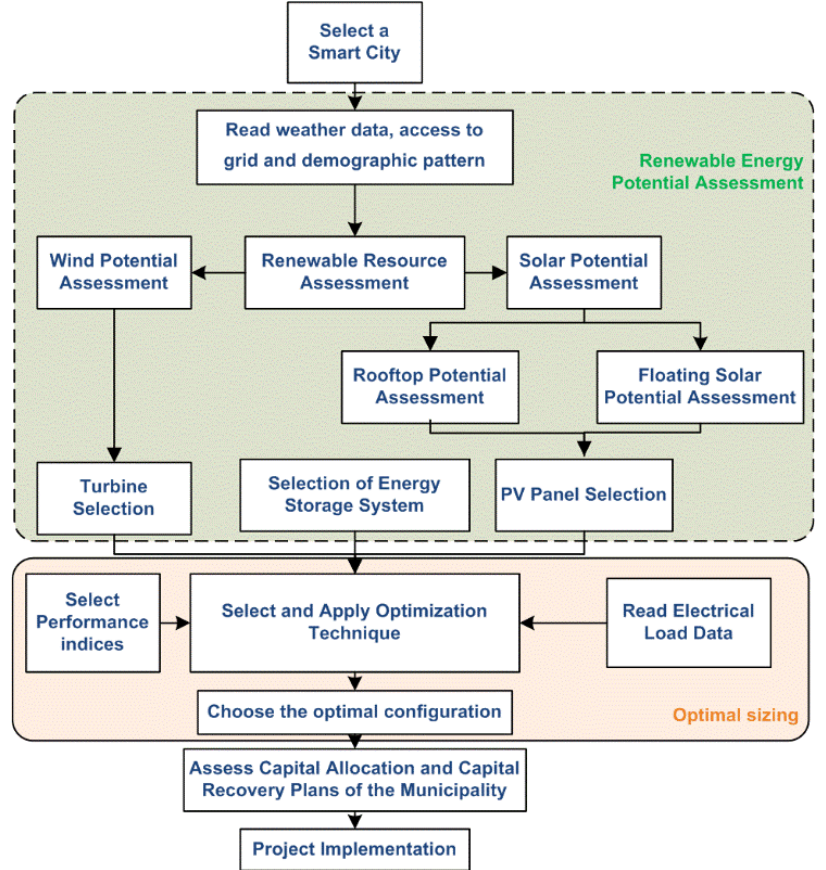
Figure 2. Process flowchart of the proposed research.